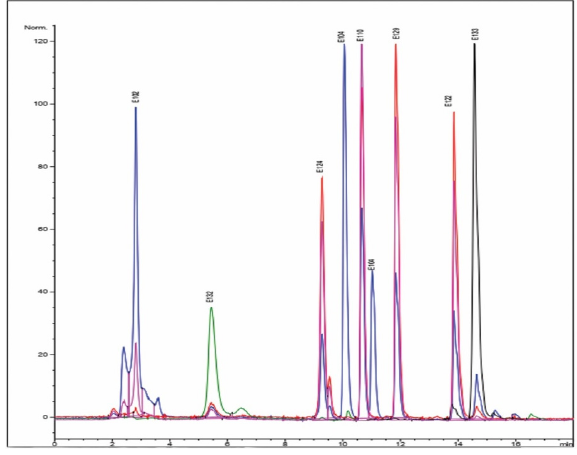
Figure 2. Chromatogram showing separation of 8 food synthetic colors at concentration of 2 µg/mL (overlaid signals from 427,482,515 and 630 nm